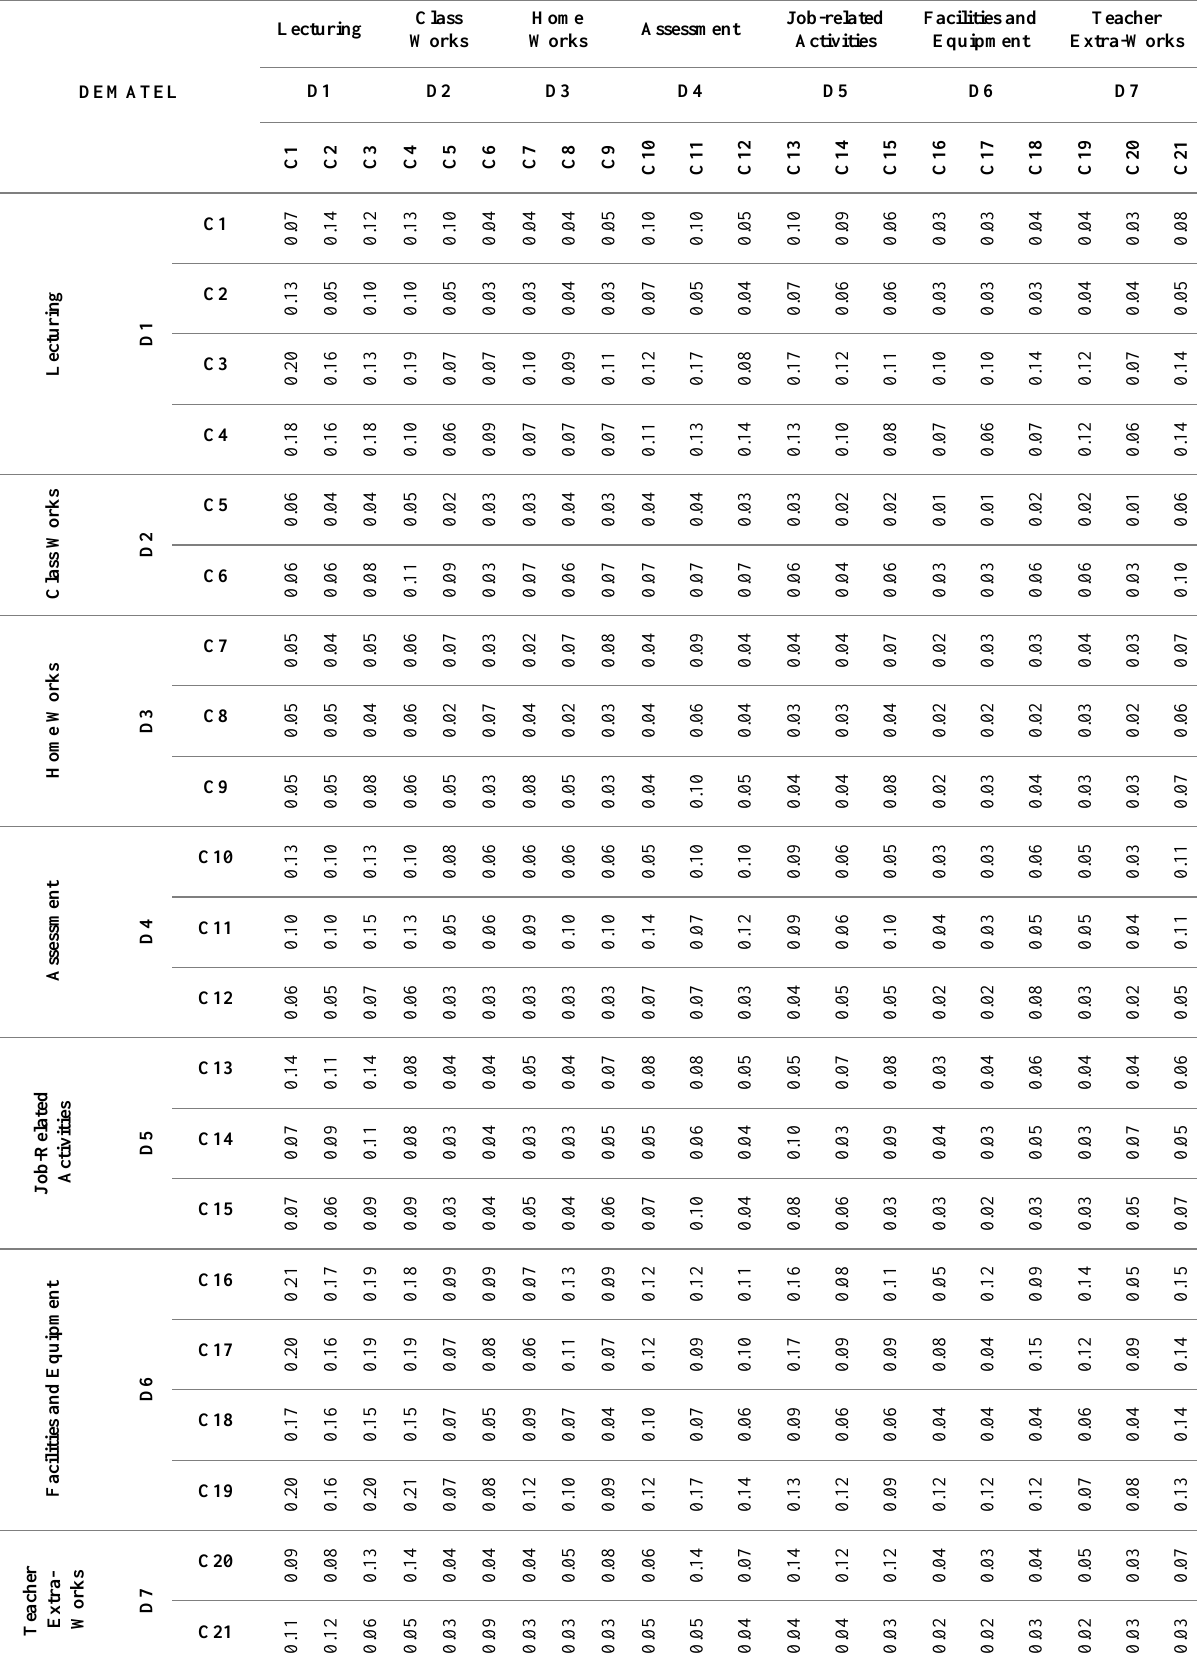
Table 9. Total influence matrix (T C